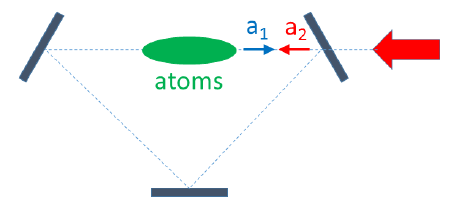
Figure 2. Schematic CARL configuration: a cold atomic gas is set on the cavity axis z , where it interacts with two counter-propagating light beams: a pump field a 2 and a probe field a 1 . The pump field is injected into the cavity from the right, through a partially-reflecting mirror; eventually, a small probe field is also injected into the cavity from the